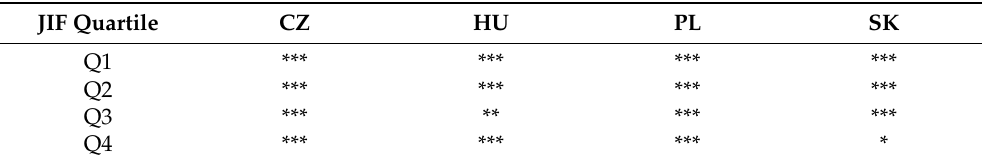
Figure 3. Comparison of category normalized citation impact (CNCI) of research papers published in Q1 – Q4 journals by V4 countries, as a function of collaboration type. The Y corresponds to the median level of CNCI. Abbreviations: CZ = Czech Republic, HU = Hungary, PL = Poland, SK = Slovakia. Table 3. The observed levels of significance when comparing the category normalized citation Impact of research papers published in international and national